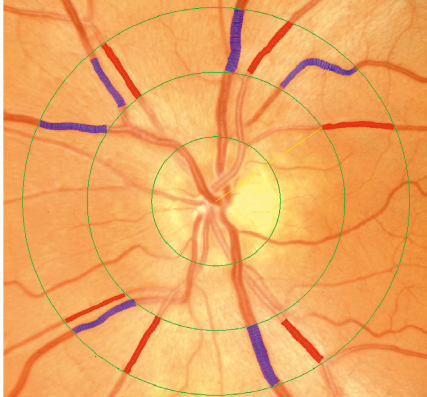
Figure 1: Automated segmentation of retinal vessel diameters from AREDS fundus photographs. The IVAN measurement grid consists of 3 concentric rings with the area of vessel measurement located 0.5 to 1.0-disc diameters away from the optic disc margin. Masked graders correct the automated measurements by adjusting grid centration, manually adding, or deleting vessels, and assigning the appropriate vessel type. Arterioles are displayed in red and venules in blue. Vessels are only measured up until the first branching point within the zone of